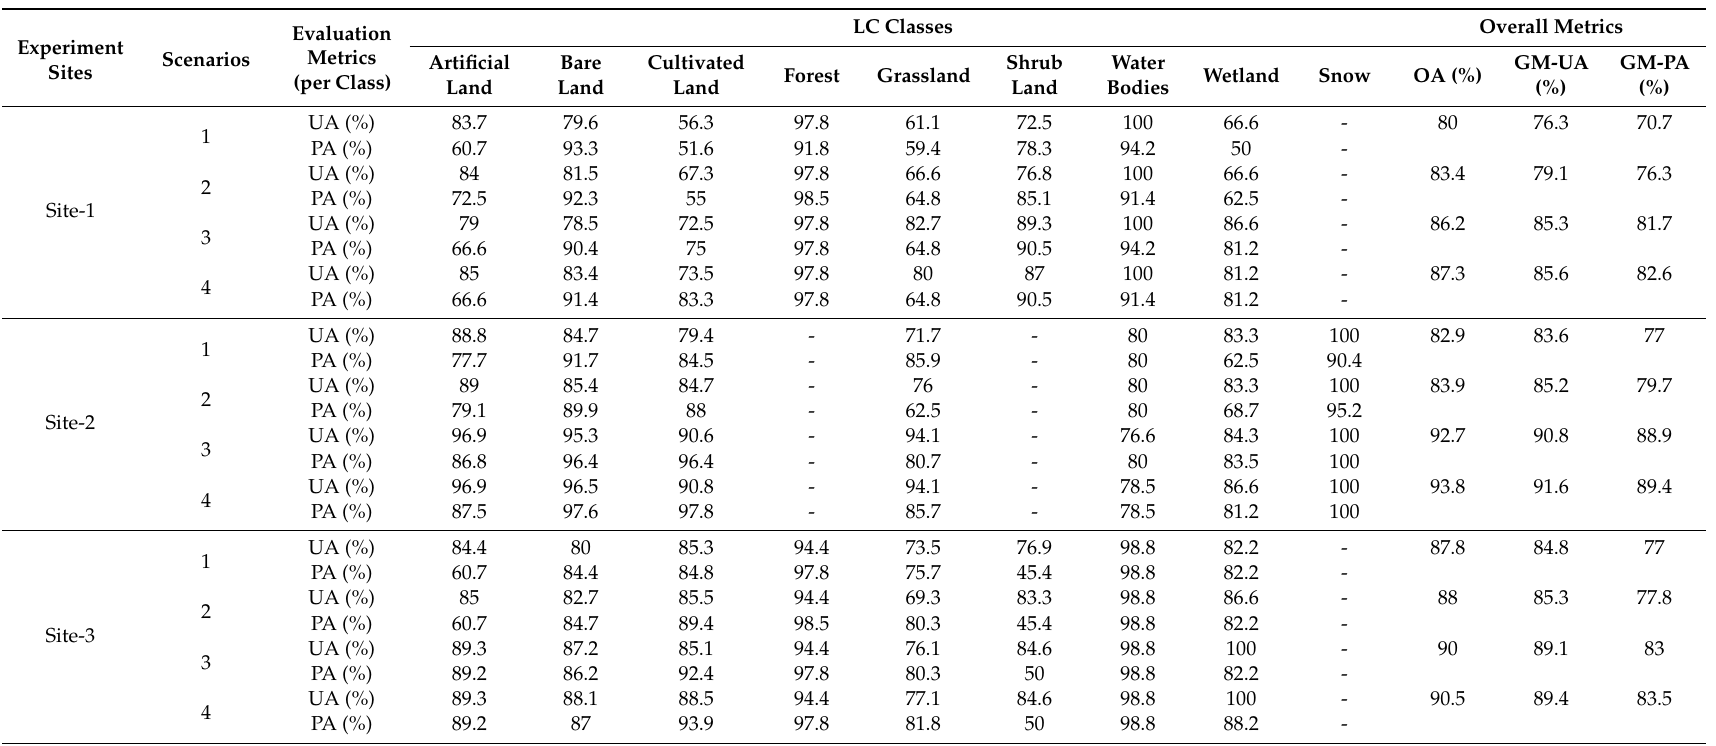
Table A2. The result of accuracy assessment using four di ff erent scenarios in the three experiment